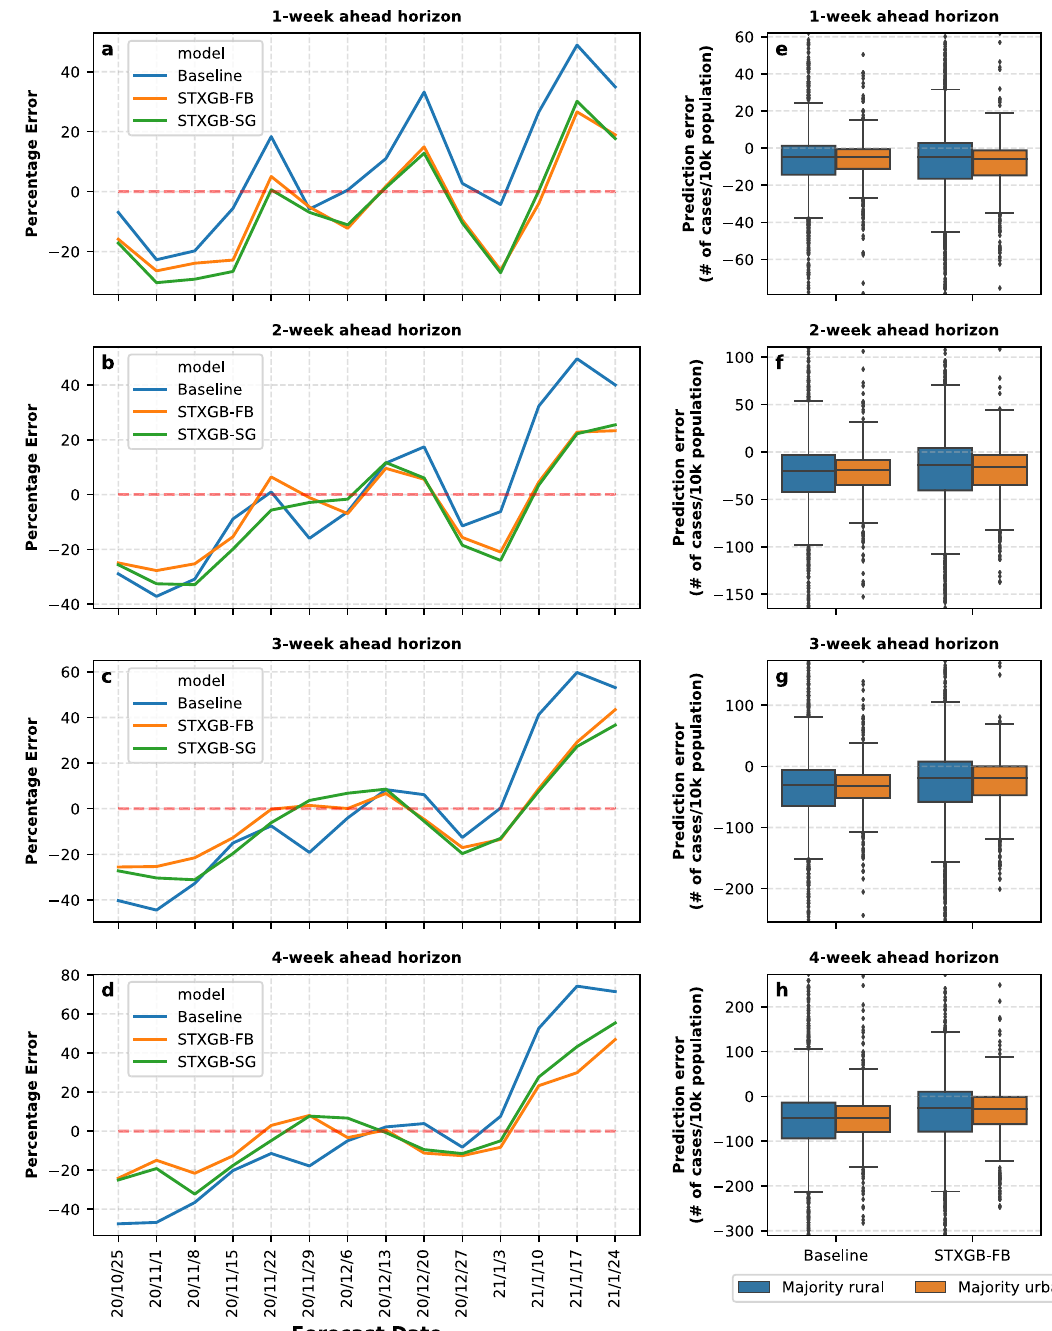
Fig. 5 Percentage error comparison in predicting total new cases and prediction errors in urban vs. rural counties. a – d The percentage error of STXGB- FB, STXGB-SG, and COVIDhub-Baseline models when predicting the total number of new cases in each prediction horizon. The percentage error is calculated by dividing the difference between the predicted and observed value by the observed value of total (in all counties) new cases. a One-week, b two-week, c three-week, and d four-week ahead prediction horizon. e – h Prediction errors of the number of new cases per 10k population in rural and urban counties on the Nov. 8 forecast date across four prediction horizons. The higher and lower 1% of counties is trimmed from the plot view. Data are presented as means ± SEM ( n = 2391 for majority rural group and n = 712 for majority urban group) and whiskers represent 1.5